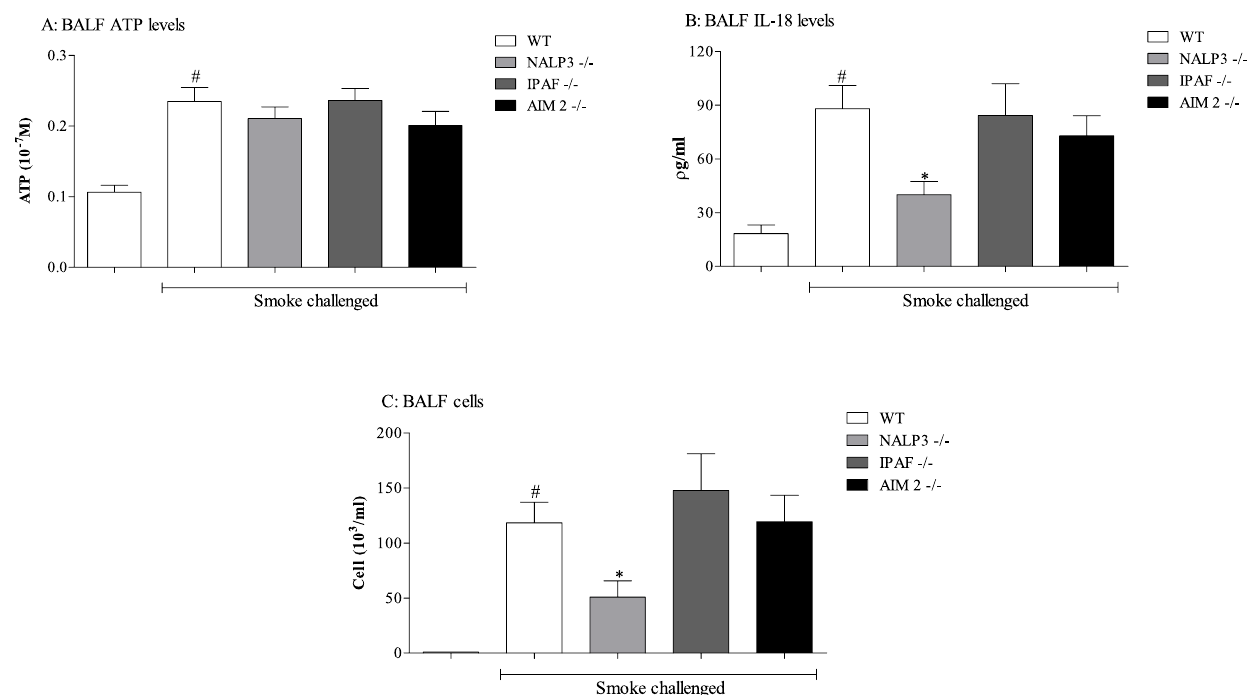
Figure 1. Role of the inflammasome proteins in the CS-driven model. NALP3, IPAF or AIM2 -/- mice were exposed to CS or room air (control) twice daily for 3 consecutive days alongside wild-type controls. BALF was collected 24 hours after the last exposure for measurement of ATP (A), IL-18 (B) and neutrophil (C) levels. Data are represented as mean 6 S.E.M. for n=8 animals in each group. Statistical significance was determined using Mann-Whitney U test. # =P , 0.05, denoting a significant difference between the smoke exposed and air exposed wild-type groups; * =P , 0.05, denoting a significant difference between the smoke exposed knock-outs and wild-types (one-way ANOVA).